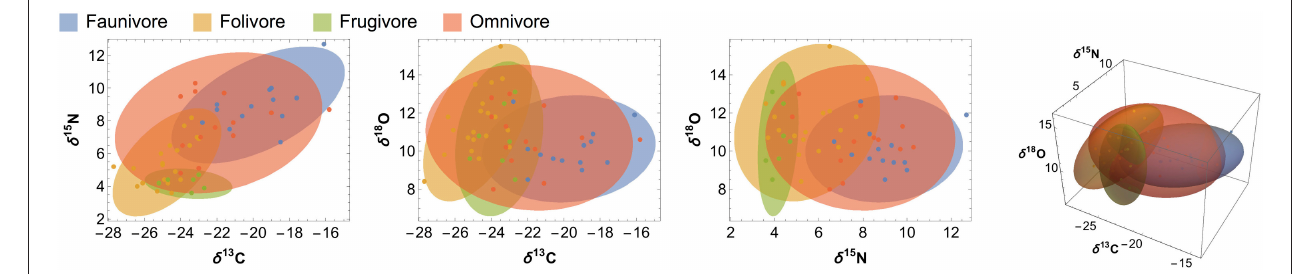
FIGURE 5 | Ninety-five percent confidence ellipses and ellipsoids illustrating overlap among 2- and 3-dimensional isotope systems for each dietary category. Raw data points are included to illustrate ellipsoid fit.